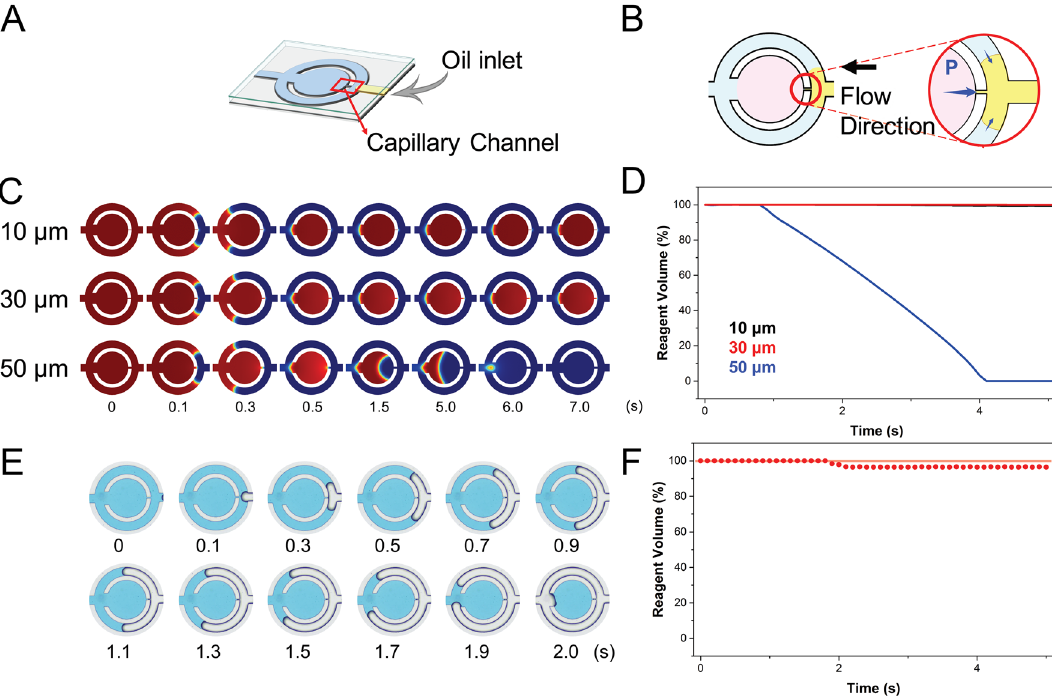
Figure 3. Oil enclosure performance of the MF-LAMP chip with varied capillary channels. ( A ) Schematic of the oil inlet direction of the MF-LAMP chip. ( B ) Capillary force that stopped oil insertion into the reaction chamber. Illustration of mechanism is visualized by PowerPoint. ( C ) Computational simulation of the single chamber domain through the oil enclosure process with varied channel widths (10, 30 and 50 µm) and reagent volume loss. Illustration is visualized by COMSOL ( D ). ( E ) Actual oil enclosure process with blue dye used as the LAMP reagent for visualization; the reagent volume variation is plotted in ( F ) and shown as red